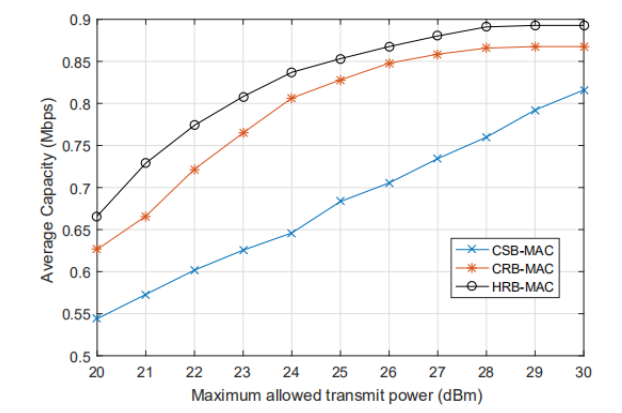
Figure 3. Average capacity against bit error rate